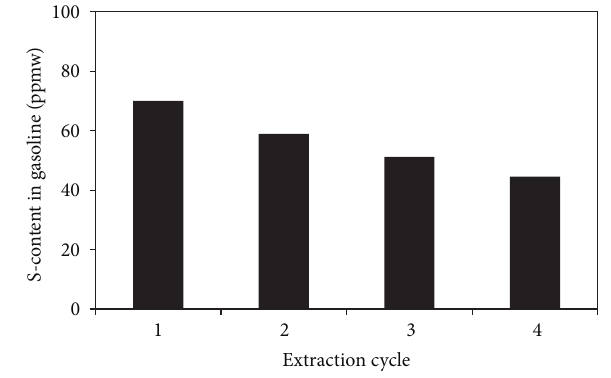
Figure 11: The multistage extraction performance of [BMIM]Cl for gasoline. (Temperature = 30 ∘ C, Mass ratio of gasoline/IL = 5 :1, Extraction time = 30 min, Initial Sulfur Concentration = 186